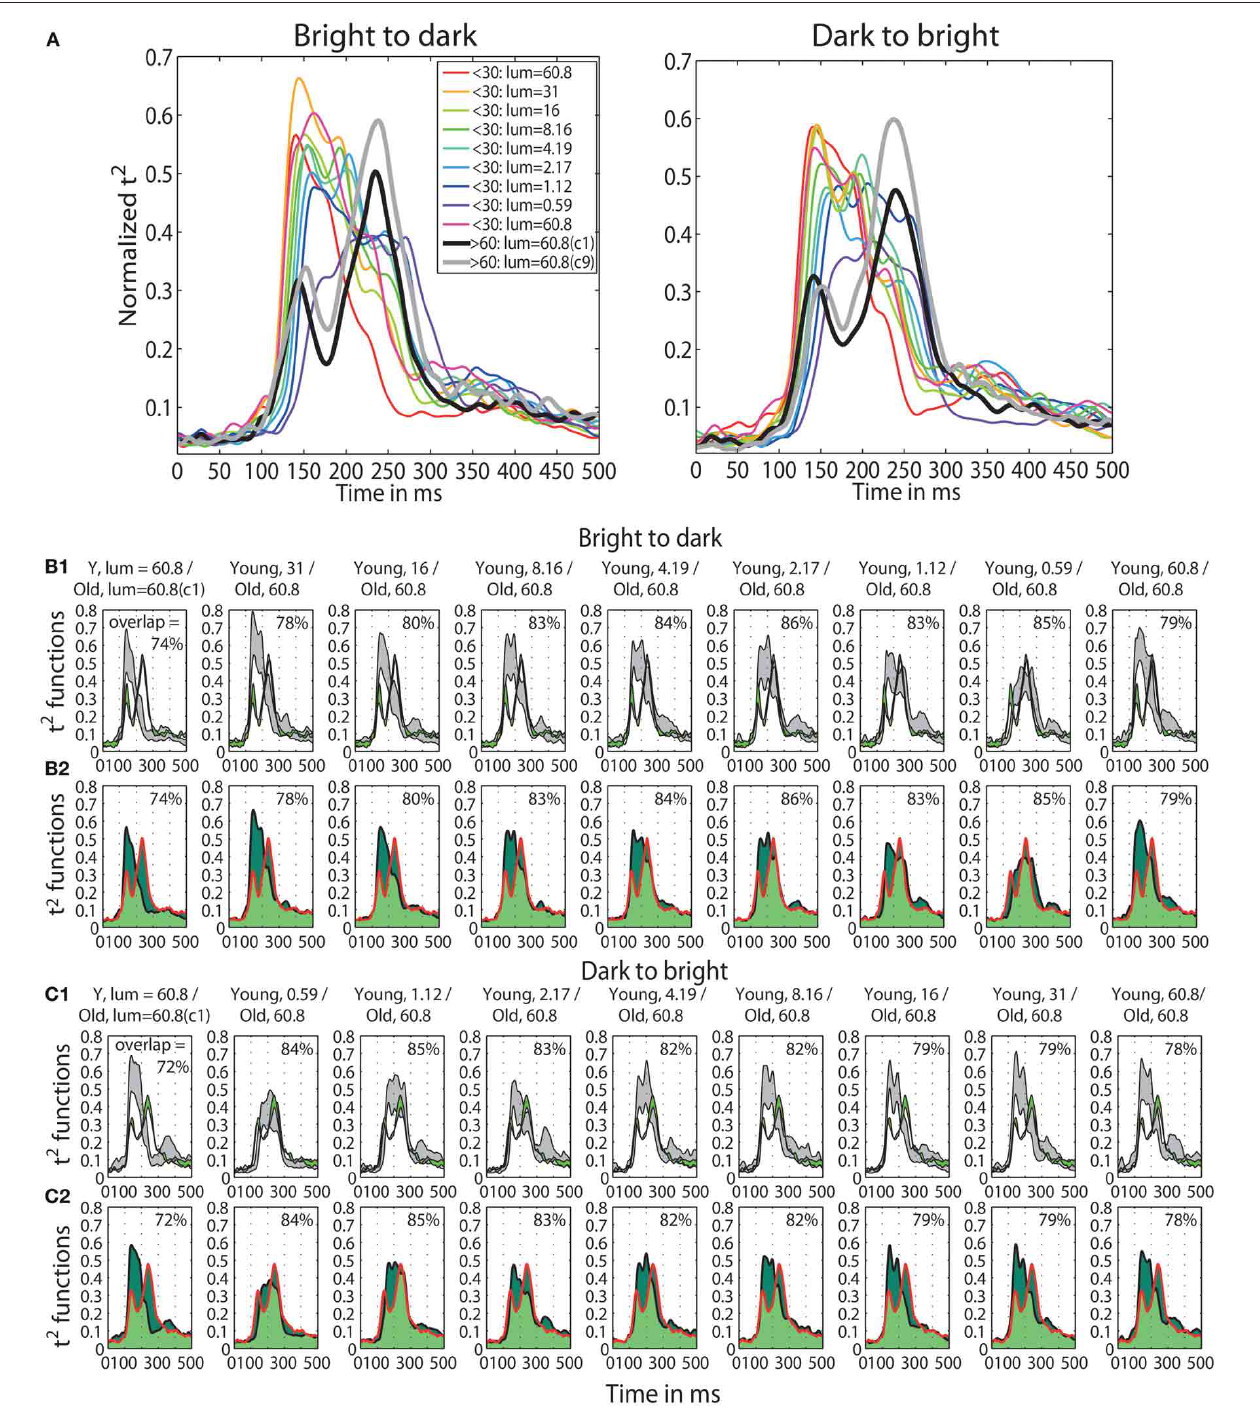
old subjects (in green) in the first brightest condition (luminance = 60.8cd/m 2 ). (B2,C2) Overlaps between young and old t 2 functions. Each subplot depicts the area under the t 2 function of young ( < 30) and old ( > 60) subjects shaded in dark green. The edges of the young t 2 functions are black, those of old t 2 functions are red. The overlap between t 2 functions for young and old subjects is shaded in light green. The proportion of overlap is given inside each subplot and the luminances are given in the title of each subplot.